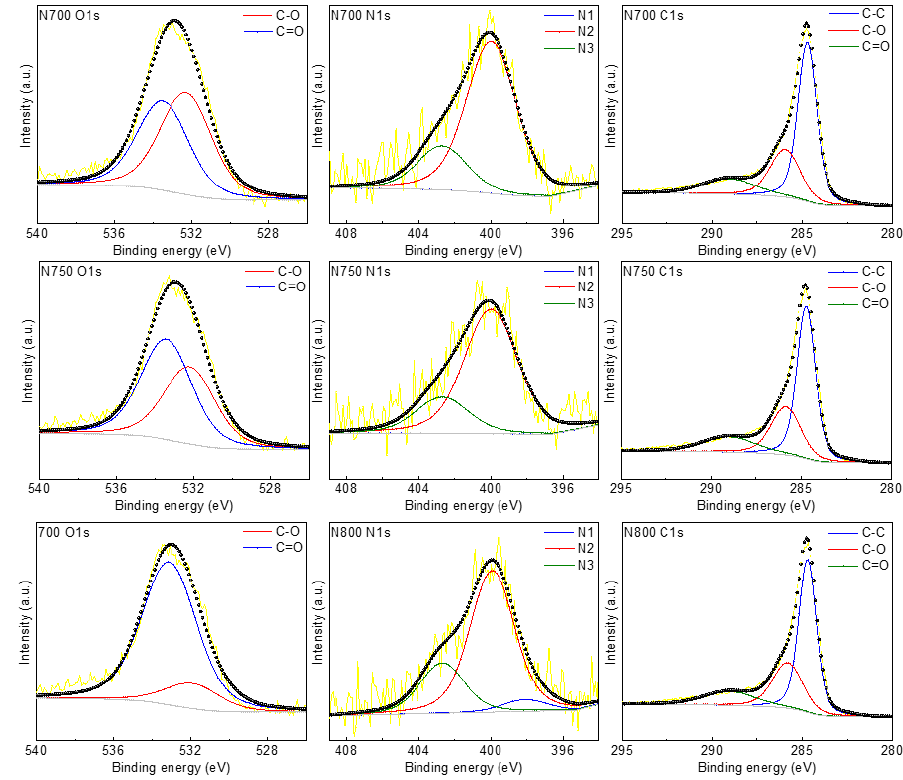
Figure 5. High resolution X-ray photoelectron spectroscopy spectra in the C1s, N1s, and O1s regions for doped samples (N700, N750, and N800).